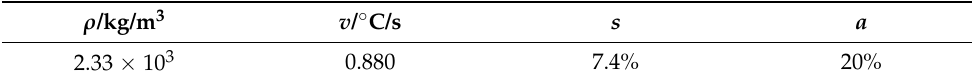
Table 6. Values in Equations (8) and (9).